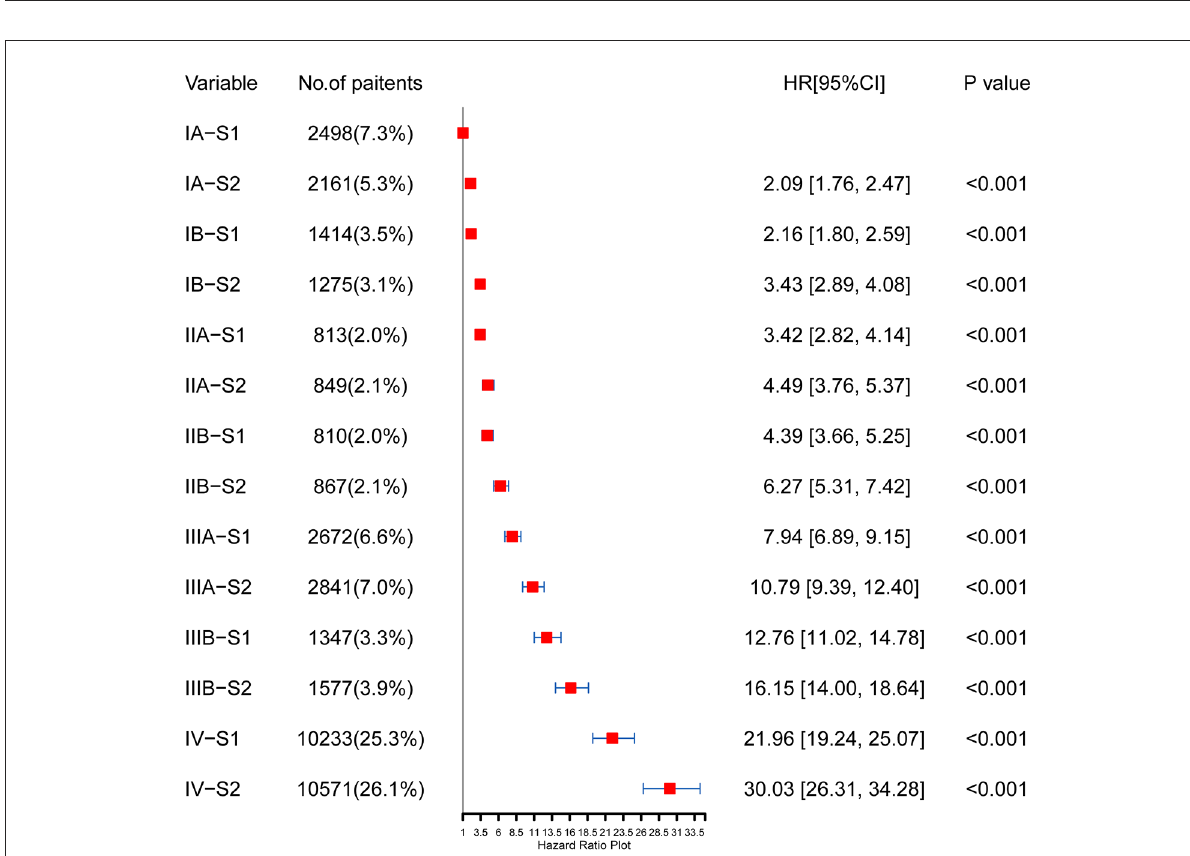
FIGURE4 Prognostic value of a novel TNM (tumor node metastasis)-SES (socioeconomic status) stage.